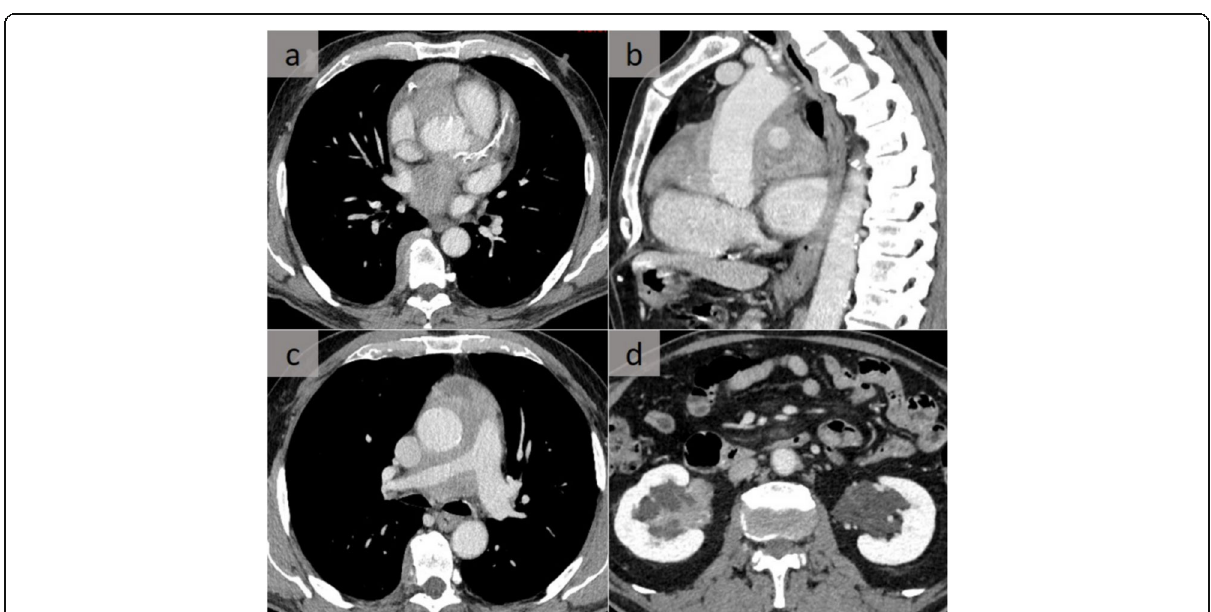
Fig. 12 Erdheim-Chester disease. Typical pattern of Erdheim-Chester disease with infiltration of the right coronary artery sulcus ( a ) and the pericardium, well assessed on a sagittal reformation ( b ). In addition to the mediastinal/pericardial involvement encasing the right pulmonary artery, note the right paravertebral thickening on axial slices ( a , c ). Renal involvement with infiltration of the sinuses was also observed ( d )